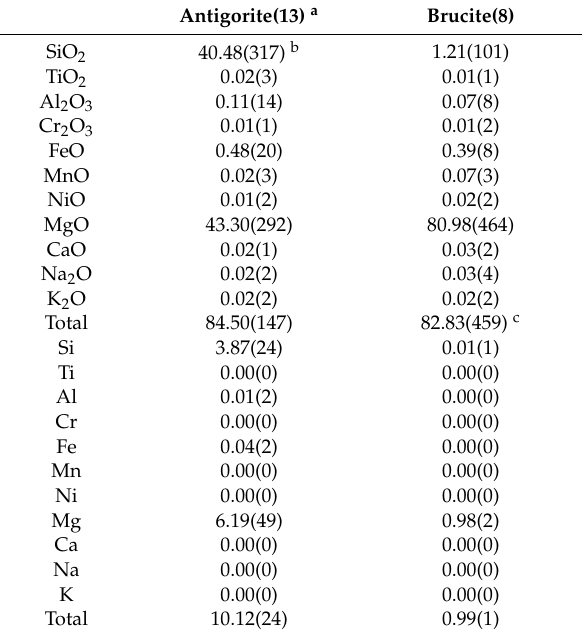
Table 3. Major element compositions (wt%) of antigorites and brucites in the